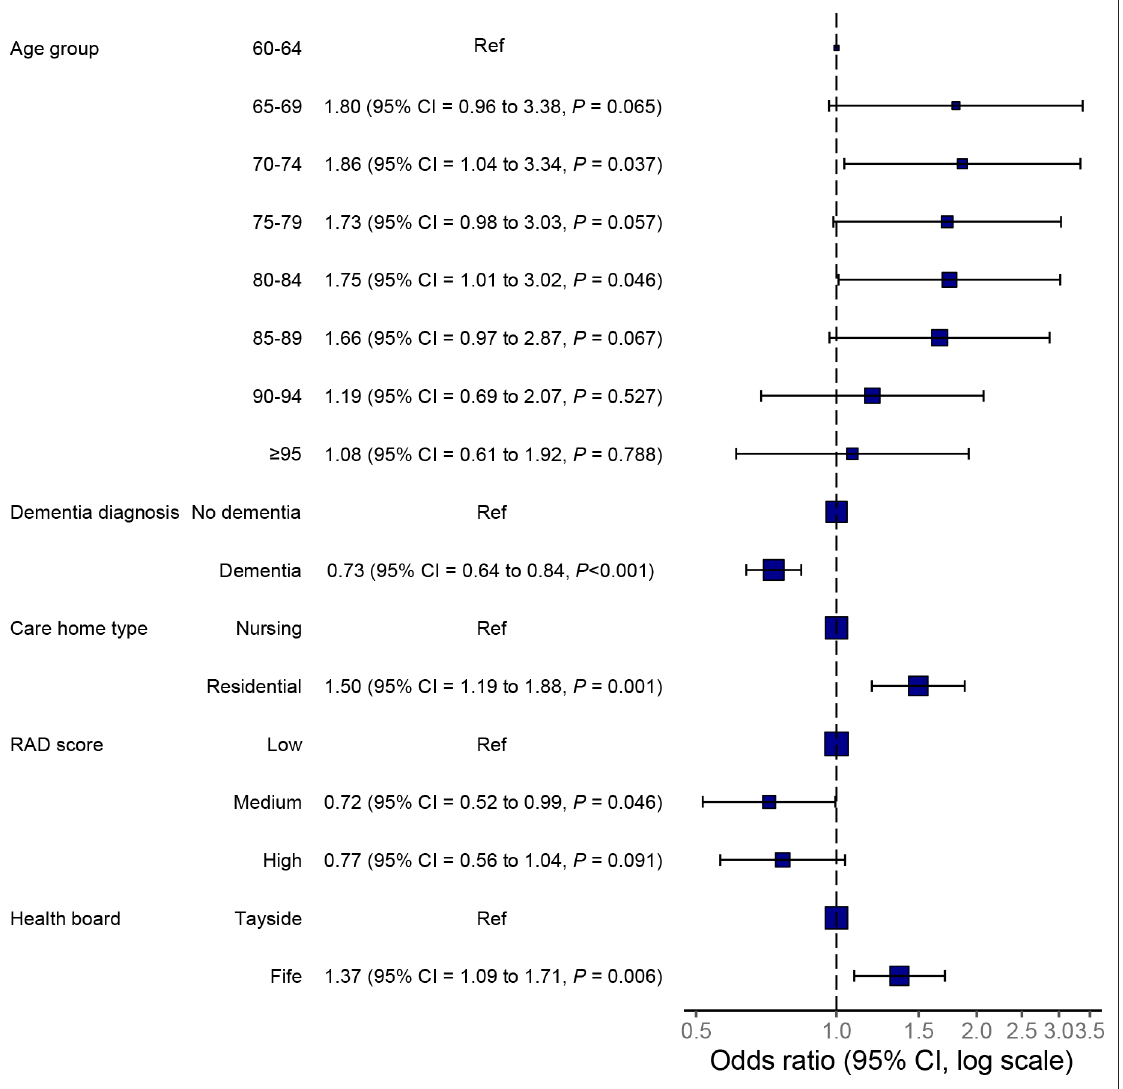
Figure 1 Multilevel logistic regression analysis of excessive polypharmacy in care home residents, adjusted model. RAD = Risk Assessment